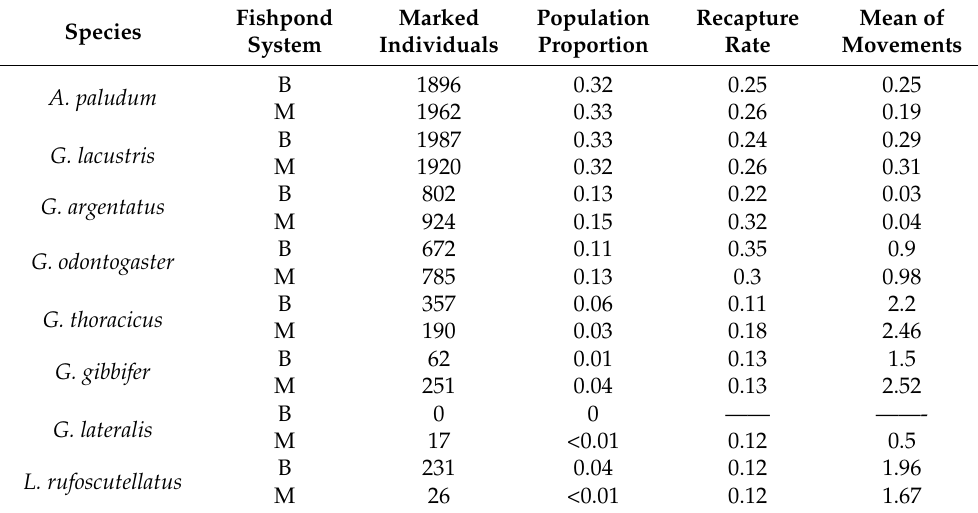
Table 4. Summary of marked individuals and catches at Bily Kamen fishponds system (B) and Mo- tovidlo fishponds system (M). Data pooled from all seasons.